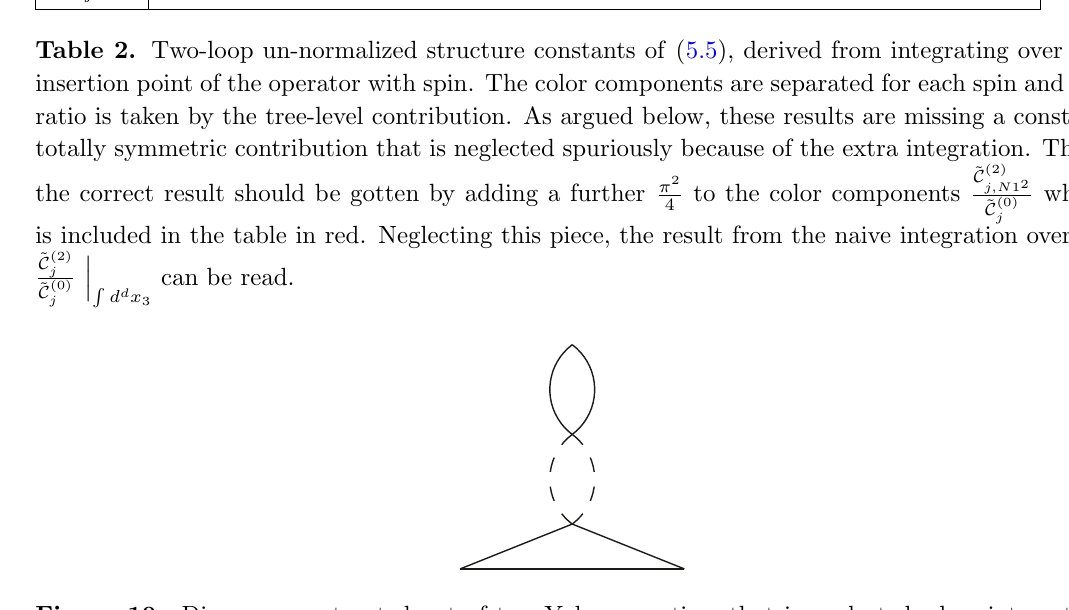
Figure 10. Diagram constructed out of two Yukawa vertices that is neglected when integrating over the exterior tip of the bubble.